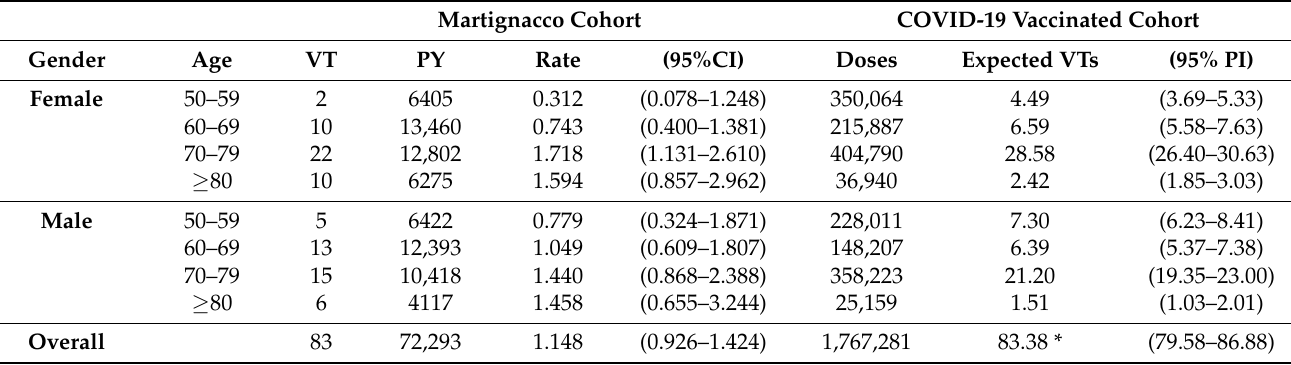
Table 1. Number of first hospitalizations for venous thromboembolism (VT), person-years (PY), the rates ( × 1000), and 95% confidence intervals (95% CI) according to gender and age classes. Number of administered doses of Vaxzevria in Italy as of 12 April 2021. Expected VT events in the 15 days following vaccination with 95% prediction intervals (95%